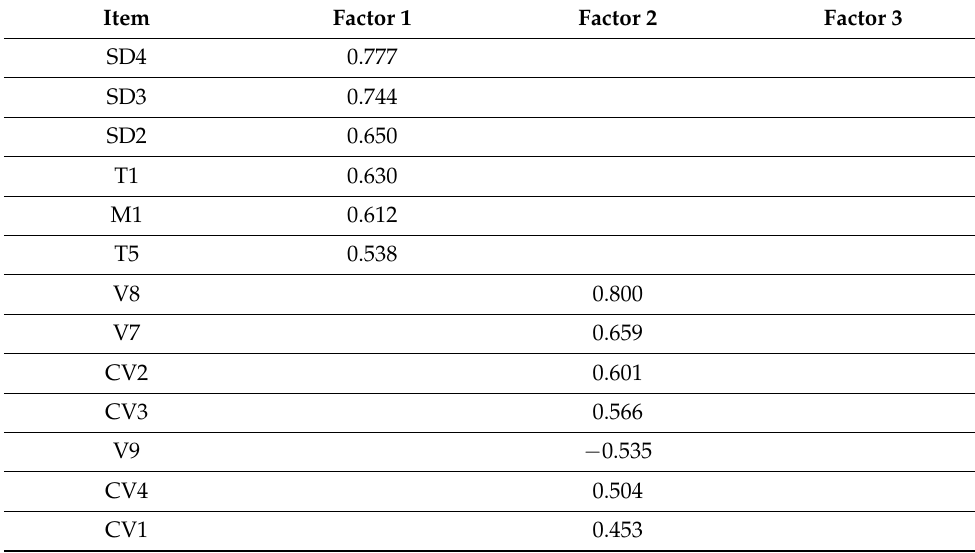
Table 4. The 3 identified components/factors of the questionnaire along with the variables that they